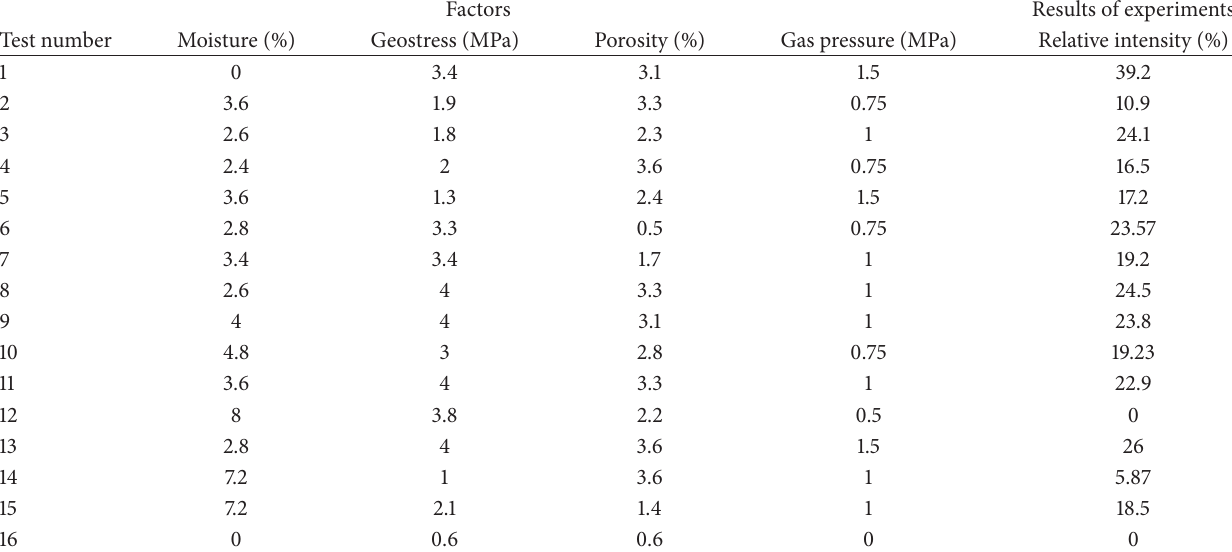
Table 3: Coupled factors and relative intensity of outburst in coal and